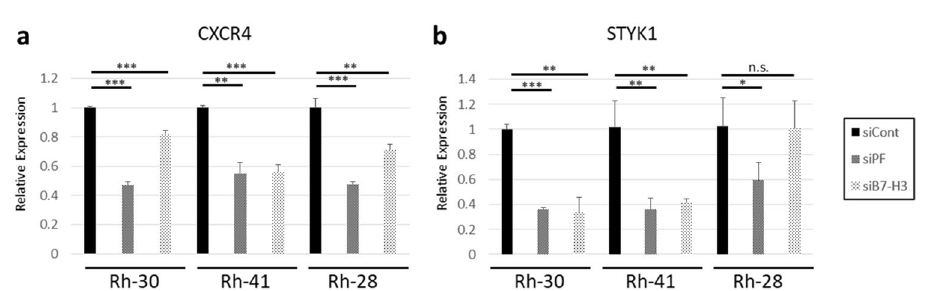
Figure 5. CXCR4 and STYK1 expression levels are regulated by PAX3-FOXO1 and B7-H3. ( a ) Quantitative real-time PCR (qRT-PCR) analysis of CXCR4 . ( b ) qRT-PCR analysis of STYK1 . Results shown represent means ± SD. * p < 0.05, ** p < 0.01, *** p < 0.001, n.s. p > 0.05, by two-tailed unpaired t